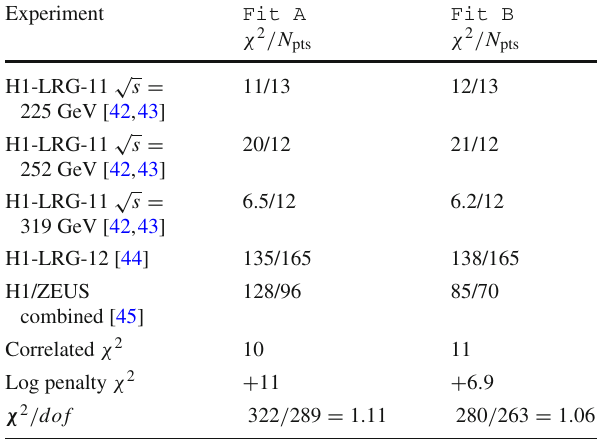
Table 3 The values of χ 2 / N pts for the data sets included in the global